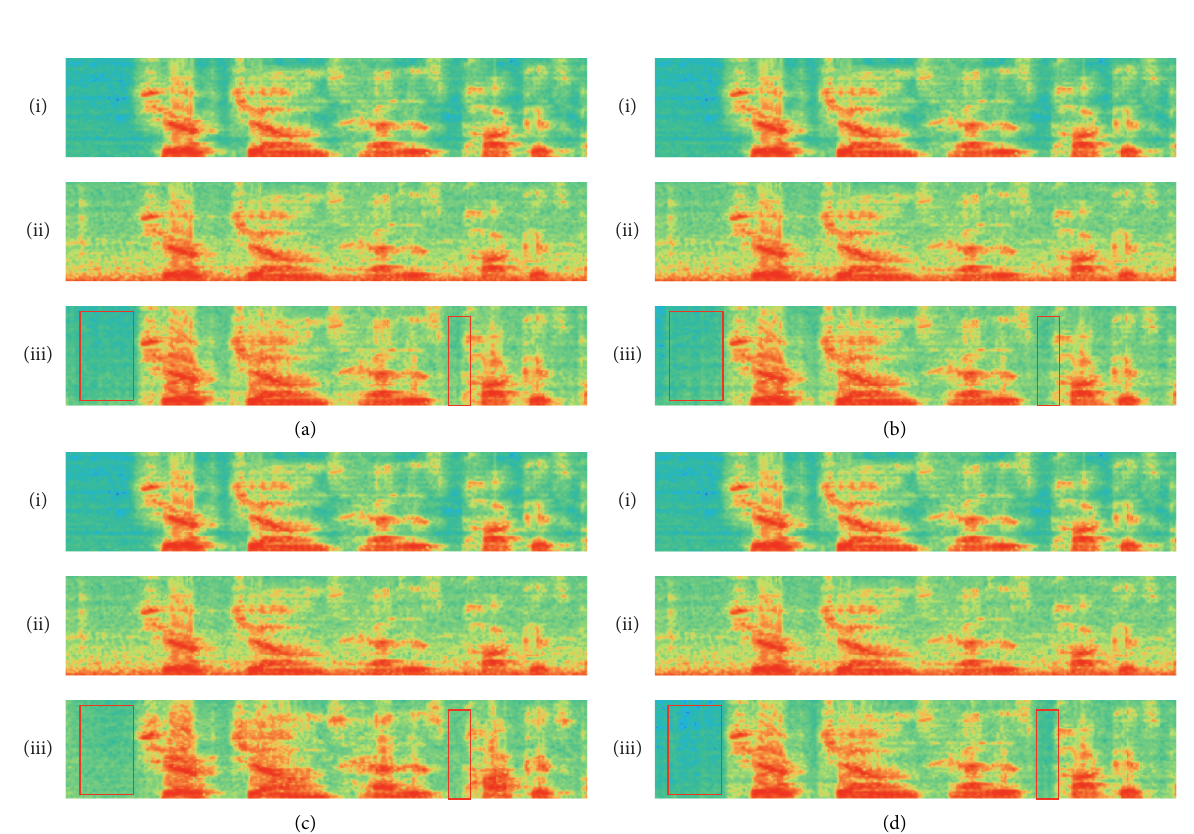
Figure 6: The spectrum of four methods under distributed 4-channel microphone array. (a) NCC method. (b) ICD method. (c) MCS method. (d) IAF method, where (i) represents clear speech, (ii) represents noisy speech with SNR � − 10dB, and (iii) represents denoised